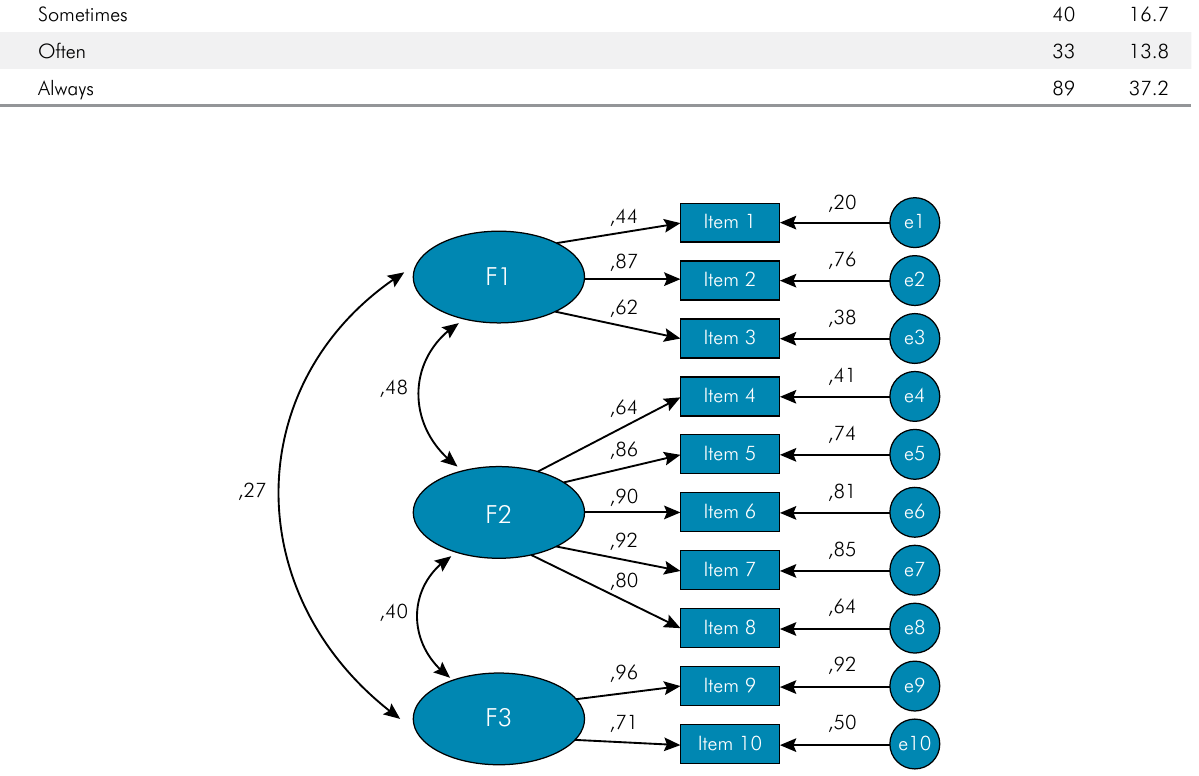
Figure. First-order three-dimensional model of the Oral Health Literacy of people with Diabetes